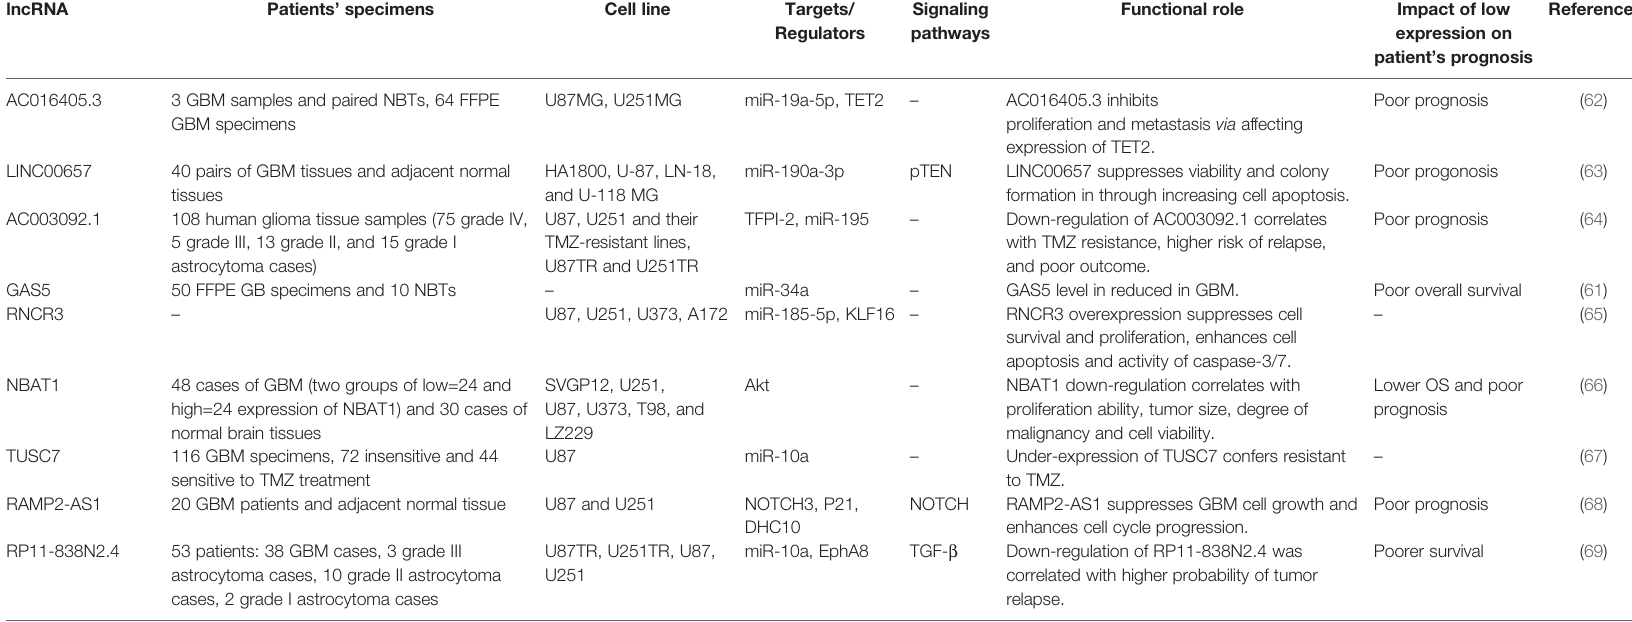
TABLE 2 | List of under-expressed lncRNAs in